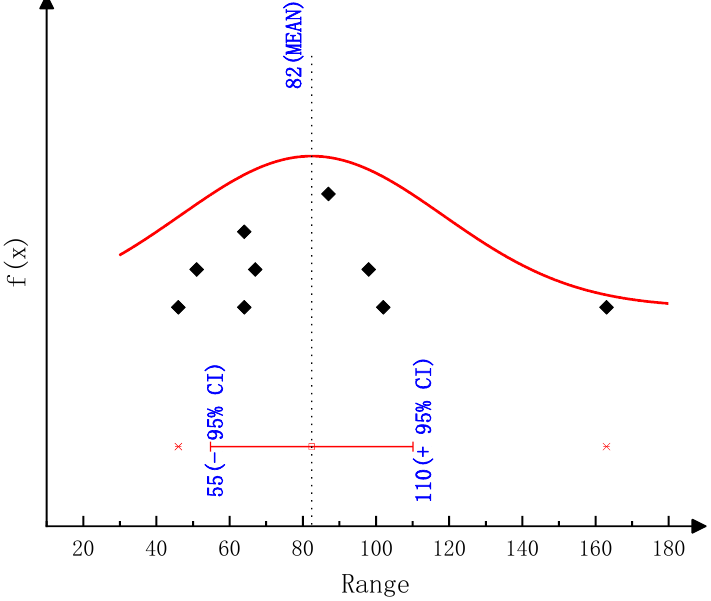
Figure A4. 95% confidence interval for the activation energy E K of urea pyrolysis reaction.